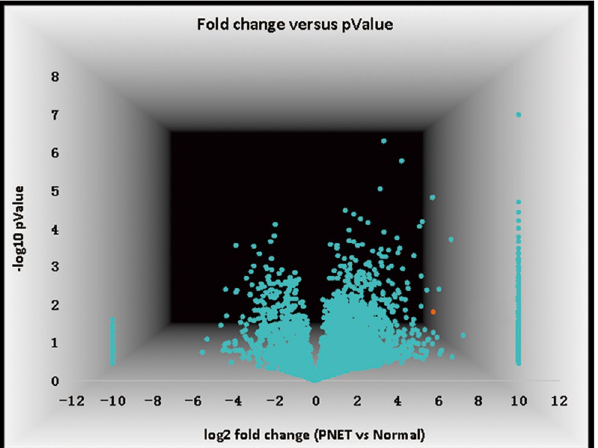
Figure 1. Volcano plot showing fold change of identified proteins between tumors and paired pancreatic specimens. The x-axis represents fold-changes of PNET versus para-tumor tissue (log2 of fold change), and the y-axis represents the statistical significance p-value ( − log10 of p-value, n = 4). The orange dots represent UCH-